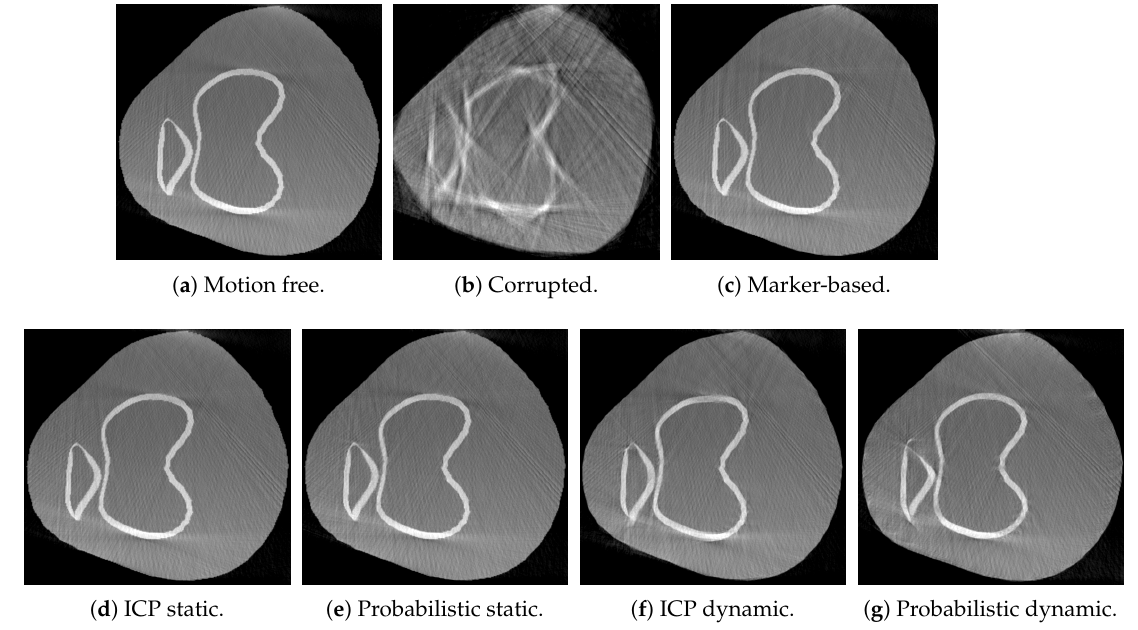
Figure 7. Reconstruction results of dataset 2: axial slices of the motion free reference volume ( a ); the motion corrupted ( b ); the marker-based corrected ( c ); and the proposed methods ( d – g